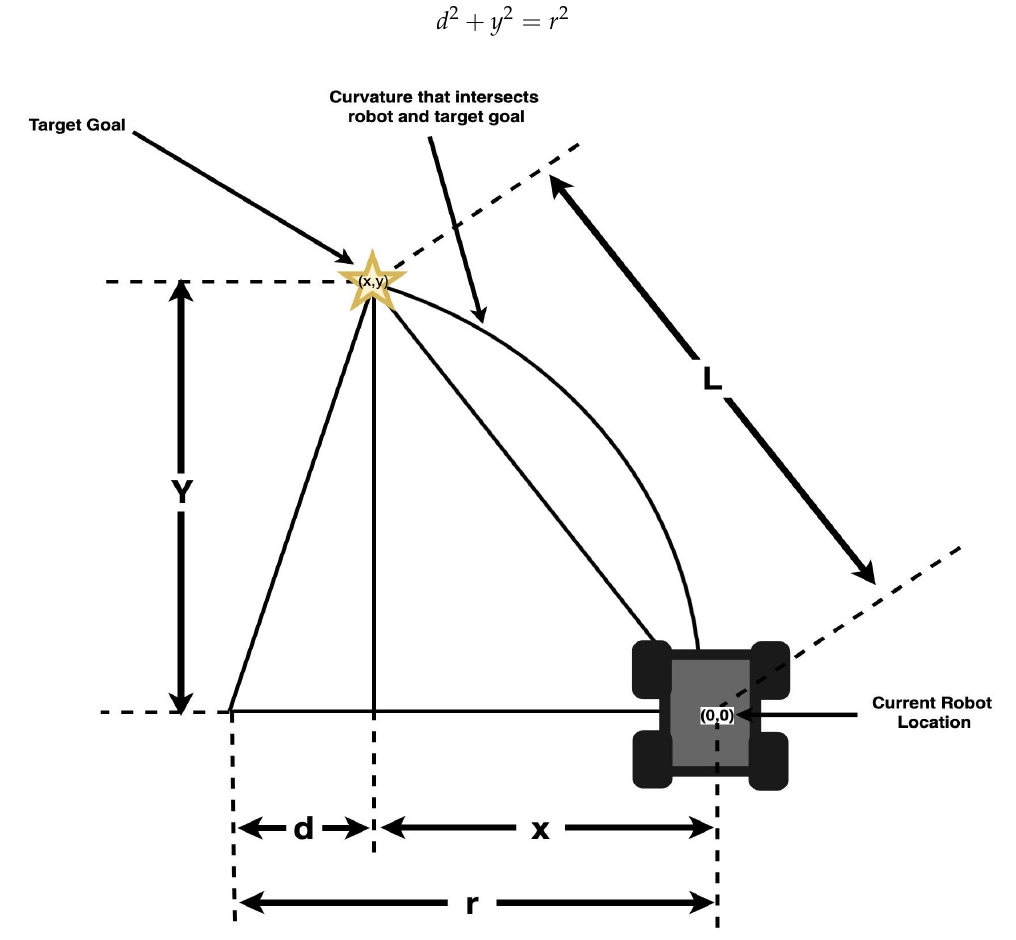
Figure 3. Geometric relationships for the pure pursuit path